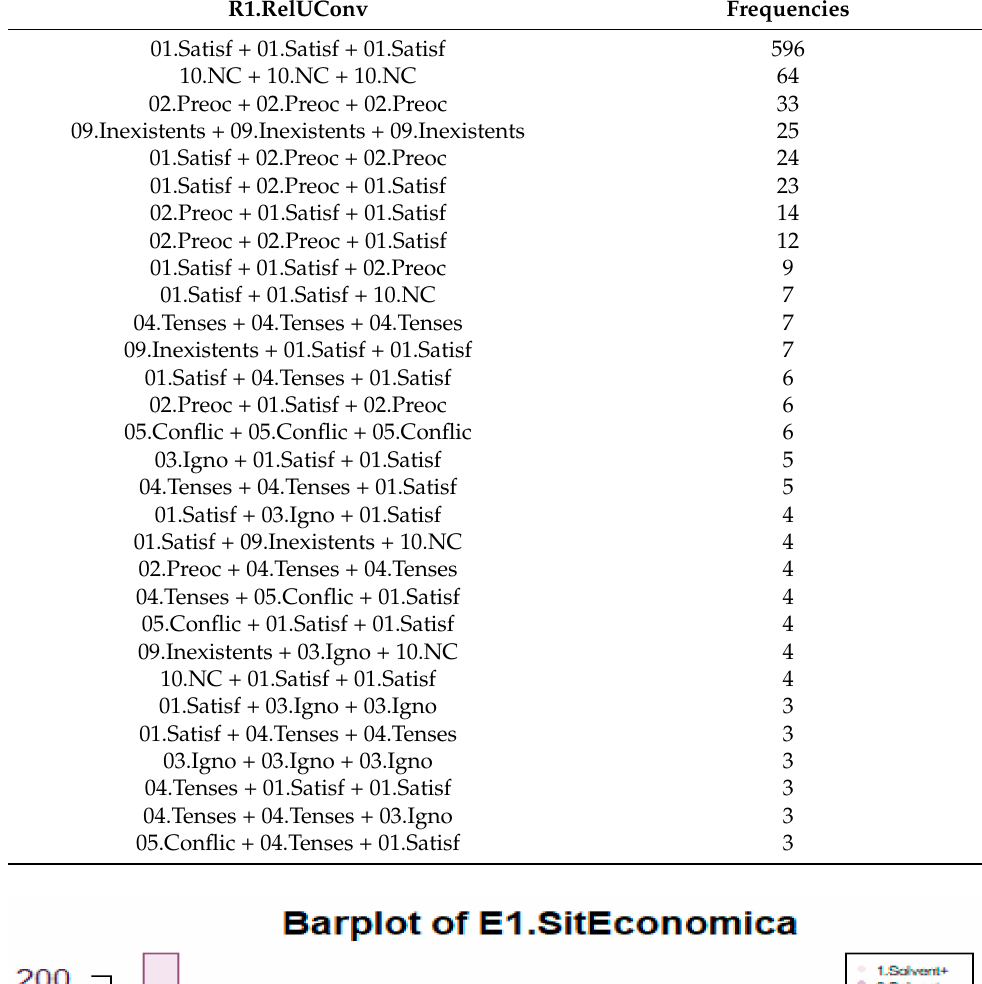
Table 5. Example of Trajectory Frequency Table.